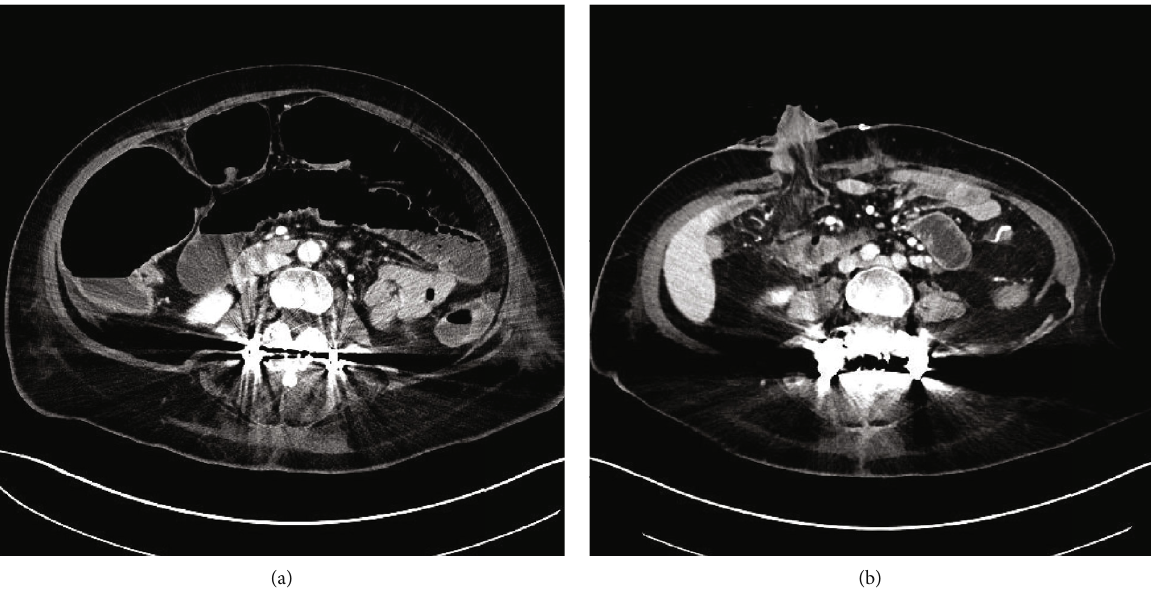
Figure 1: Pre- and postoperative abdominal CT scan. (a) Dilation of multiple small bowel and colon loops, consistent with ileus. Development of right colonic pneumatosis and multiple locules of free intraperitoneal air concerning of underlying perforation. (b) Interval decrease in subcutaneous fl uid collection underlying the incision. No evidence for intraperitoneal or abdominal wall fl uid collections. Stable to mildly increased stranding in the mesentery underlying the stoma may represent postoperative changes or developing fat necrosis.